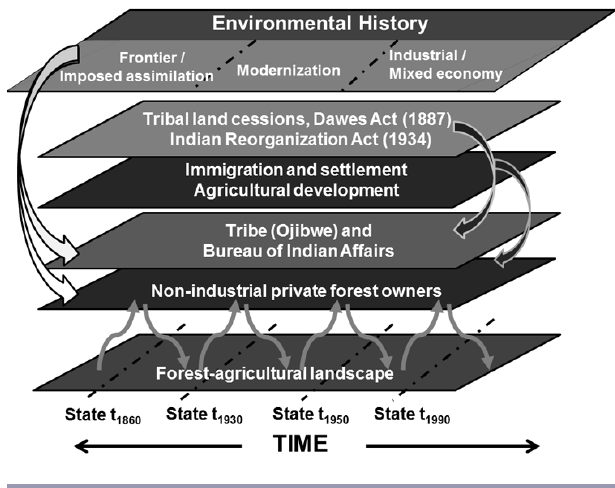
Fig. 4. Application of integrative environmental history- coupled human and natural systems framework to the human- forest landscape system on the Lake Superior clay plain,